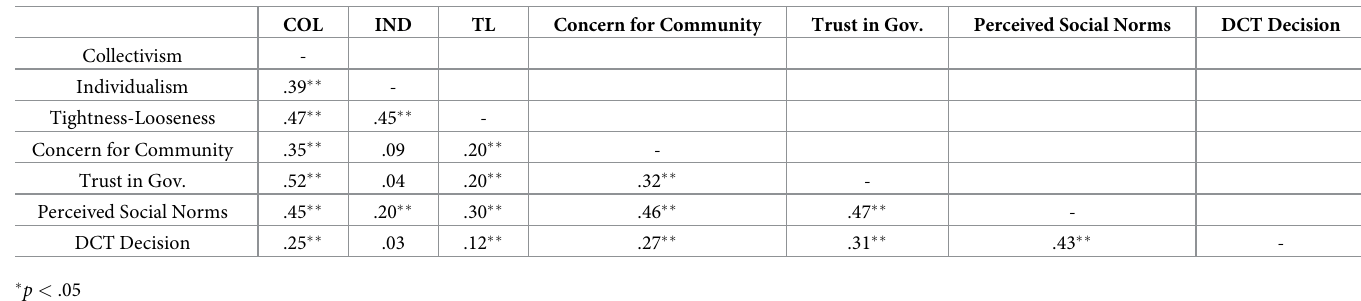
Table 3. Zero-order correlations between key variables related to digital contact tracing (DCT). COL IND TL Concern for Community Trust in